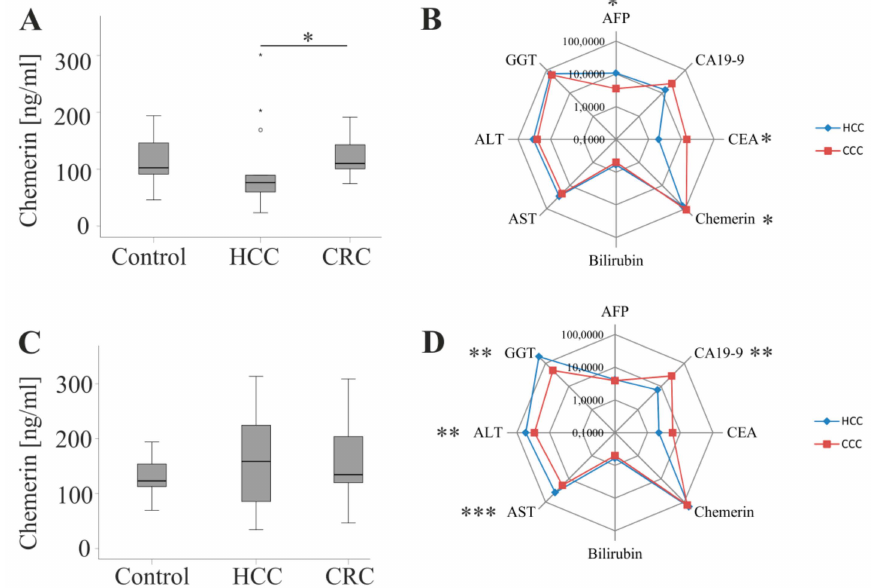
Figure 3. Serum chemerin and comorbidities. ( A ) Chemerin in 27 controls, 14 HCC and 18 CRC patients not su ff ering from hypertension, hypercholesterolemia or hyperuricemia. ( B ) Spider diagram presentation of chemerin, carcinoembryonic antigen (CEA), cancer antigen 19-9 (CA19-9), alpha-fetoprotein (AFP), γ -glutamyltransferase (GGT), alanine aminotransferase (ALT), aspartate aminotransferase (AST) and bilirubin in the serum of HCC and CRC patients described in A. The spider diagram shows the respective median values on a logarithmic scale. ( C ) Chemerin in 22 controls, 18 HCC and 18 CRC patients su ff ering from hypertension, hypercholesterolemia or hyperuricemia. ( D ) Spider diagram presentation of chemerin, CEA, CA19-9, AFP, GGT, ALT, AST and bilirubin in the serum of HCC and CRC patients described in C. The spider diagram shows the respective median values on a logarithmic scale. * p < 0.05, ** p < 0.01, *** p <